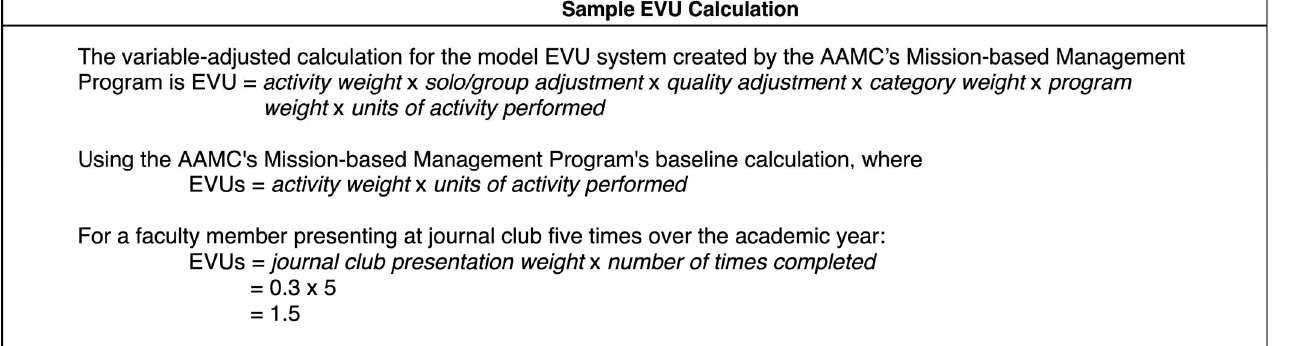
Figure 2. Sample EVU Calculation based on the EAVU Tracking Tool used at the Cincinnati Children’s Hospital Medical Center from Guiot et al. (2017) [14].